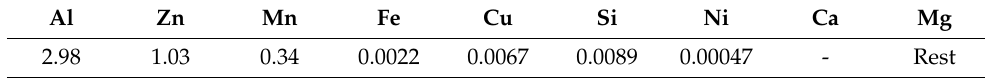
Table 1. AZ31B chemical composition (wt.%) of the as-received